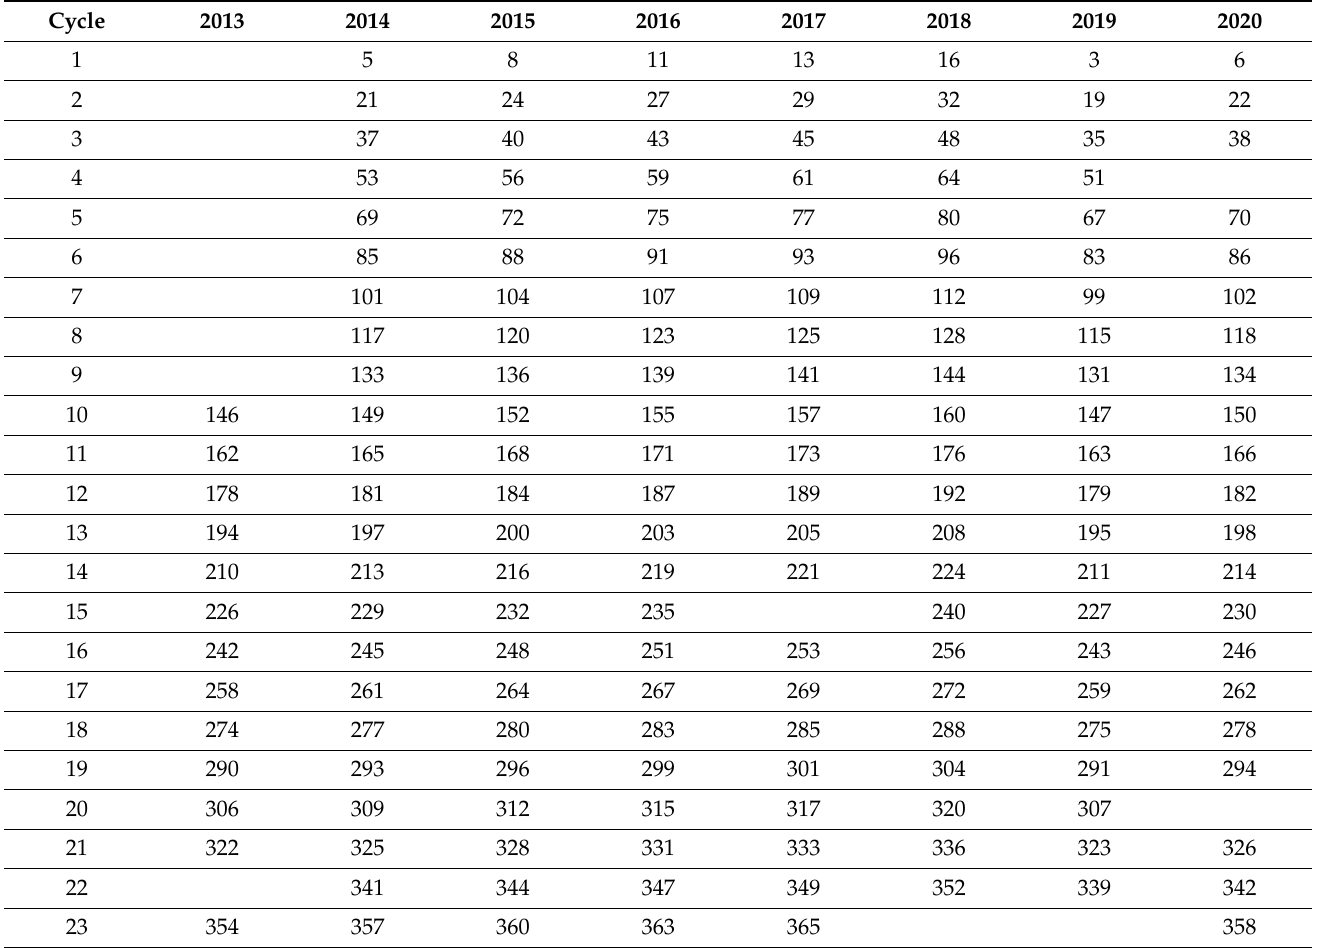
Table 1. The number of satellite images acquired from NASA/USGS Landsat OLI (2014 to present), and for this study, only scenes for each year between 2014 and 2020 were used in this